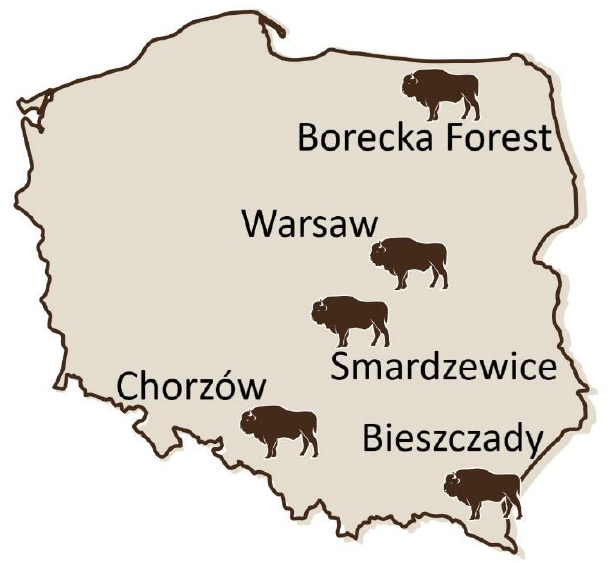
Figure 1: The location of bison